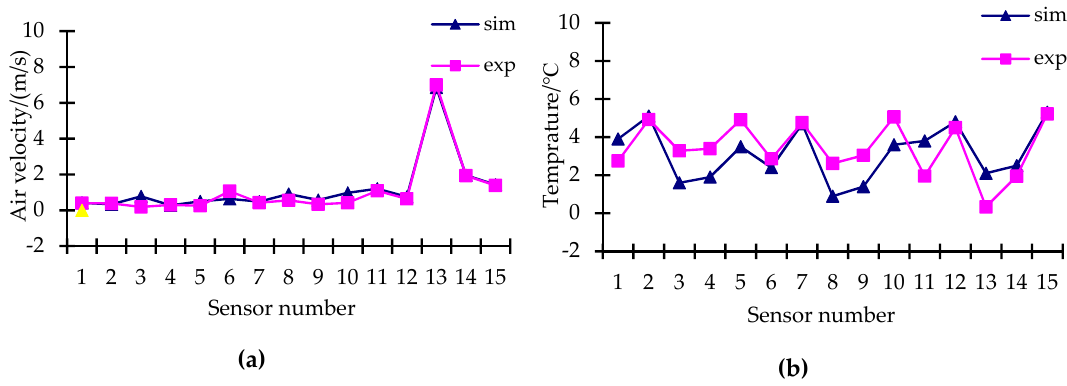
Figure 6. Comparison of simulation and experiment: ( a ) temperature and ( b ) air velocity.